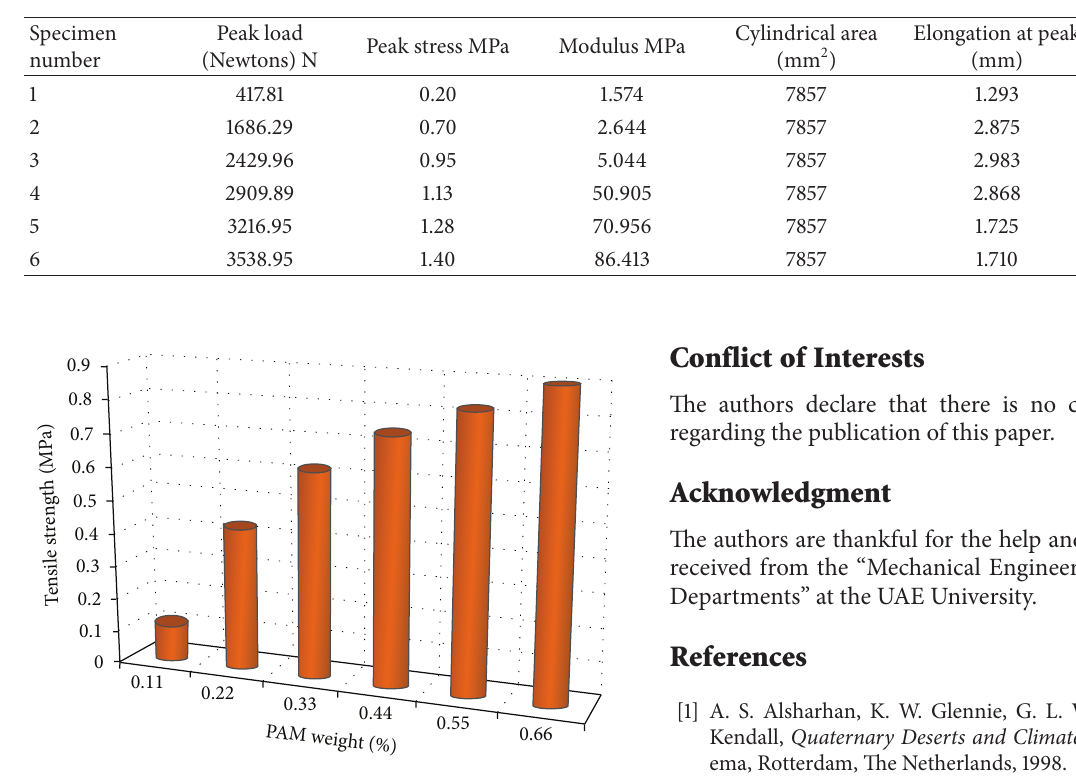
Figure 10: Tensile strength versus polymer weight percent in the sand-polymer